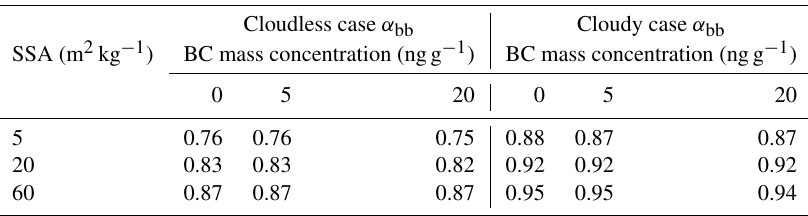
Table 4. Broadband surface albedo ( α bb ) of fresh (SSA = 60m 2 kg − 1 ) and aged snow (SSA = 5 and 20m 2 kg − 1 ) depending on the BC particle mass concentration and illumination